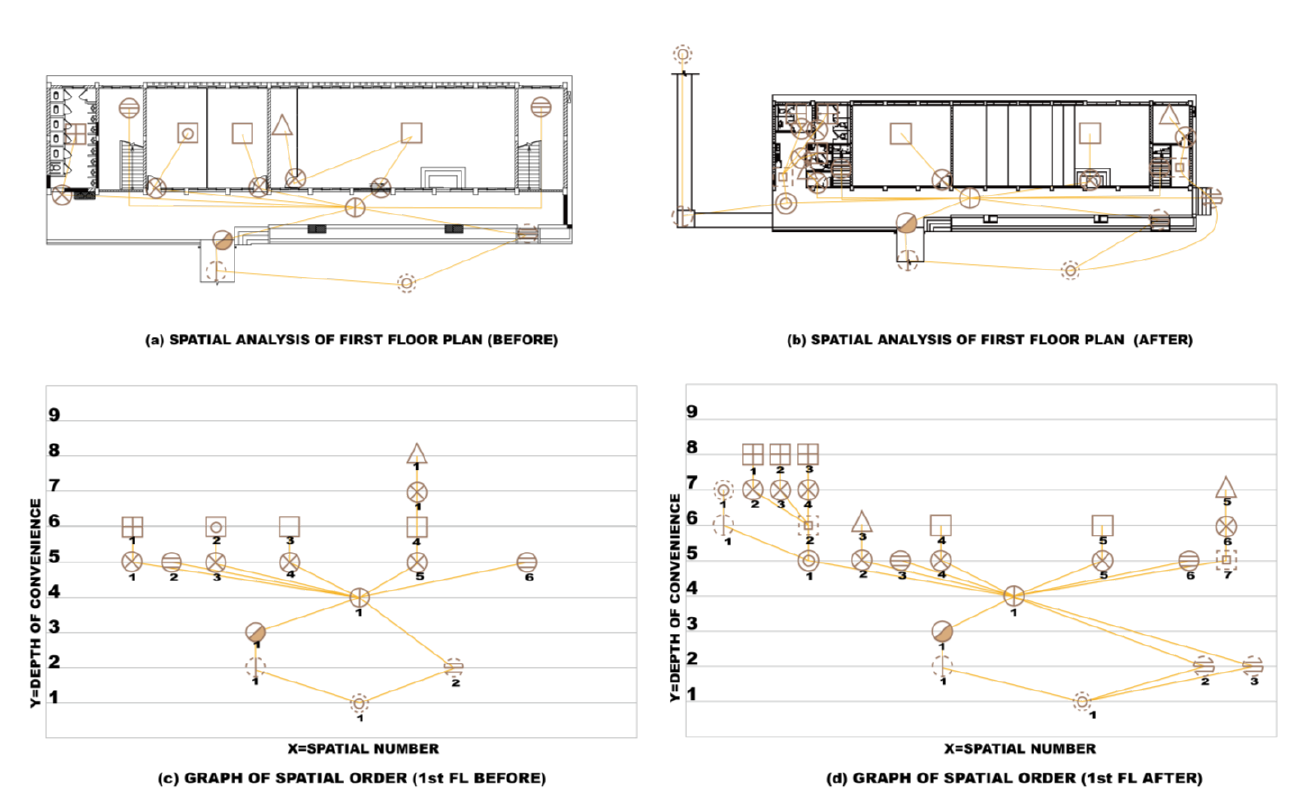
Figure 8. Past and Present’s Regeneration First Floor Plans of Checheng Elementary School Wencyuan Branch’s Space Relationship Diagrams. ( a ) Spatial Analysis (Before redesign). ( b ) Spatial Analysis (After redesign). ( c ) Spatial Order (Before redesign). ( d ) Spatial Order (After redesign).